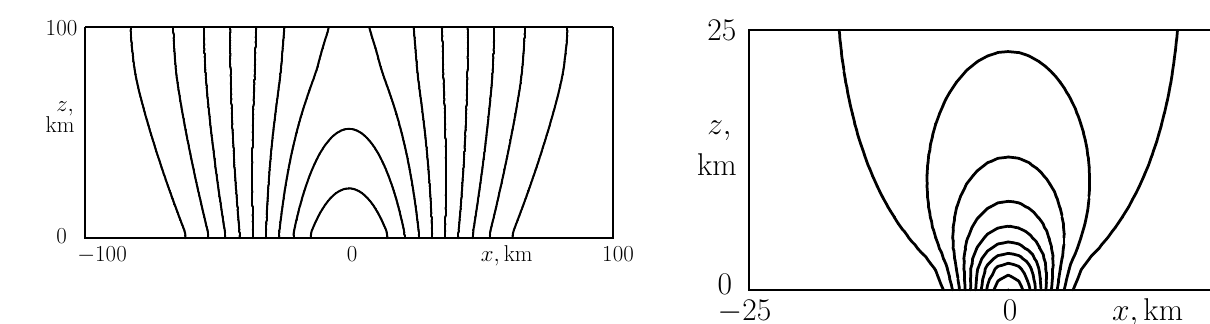
Fig. 7. Current lines for a source size dimension of a = 100km, where about 30% of the total current is closed inside the atmo- sphere. Fig. 8. Current lines for a source size dimension of a = 10km.